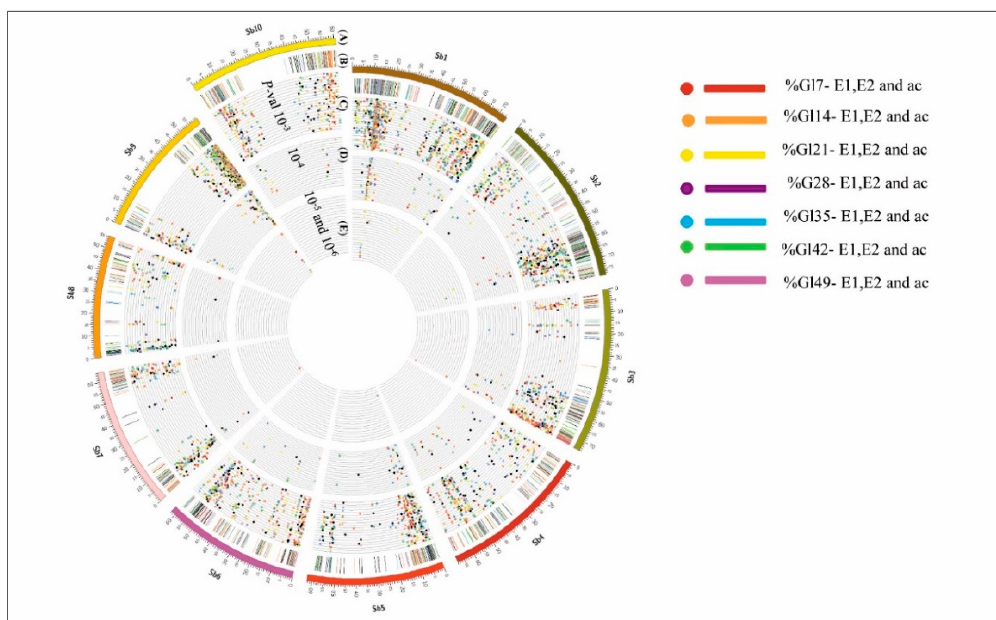
Figure 5. Stay-green trait significant MTAs in a circular plot from outside to inside aligned to the physical positions representing the ( A ) sorghum chromosomes (sb1-sb10). ( B ) Highlights for the significant SNPs overlapping regions for %GL, ( C ) significant MTAs scatter plot for the whole genome with p -value = 10 − 3 . ( D ) Significant SNPs with p -value = 10 − 4 , and ( E ) significant MTAs SNPs with p -value = 10 − 5 & 10 − 6 . Different %GL scores with red color (%GL7), orange color (%GL14), yellow color (%GL21), purple color (%GL28), blue color (%GL35), green color (%GL42), and pink color (%GL49).